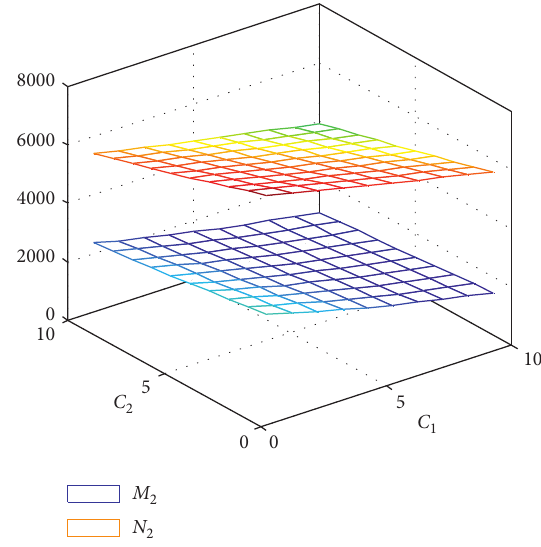
Figure 6: Service provider’s profits under decentralized and centralized